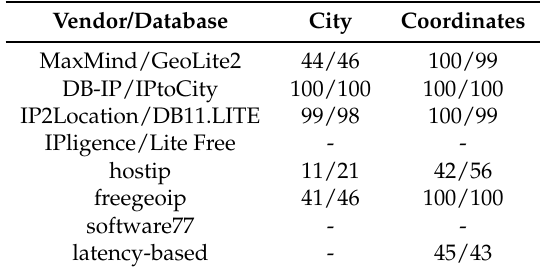
Table 8. Location efficiency—returned locations for small/large cities ( p < 17,000/ p > 17,000) [%].